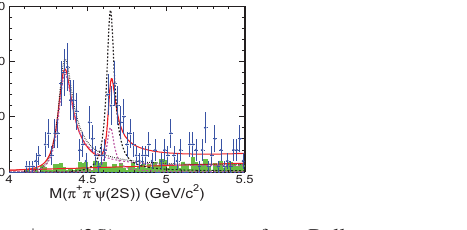
Figure 3. The π + π − ψ (2 S ) mass spectrum from Belle measurement (dots with error bars) and the fits with sum of two (left) or three (right) BW functions.